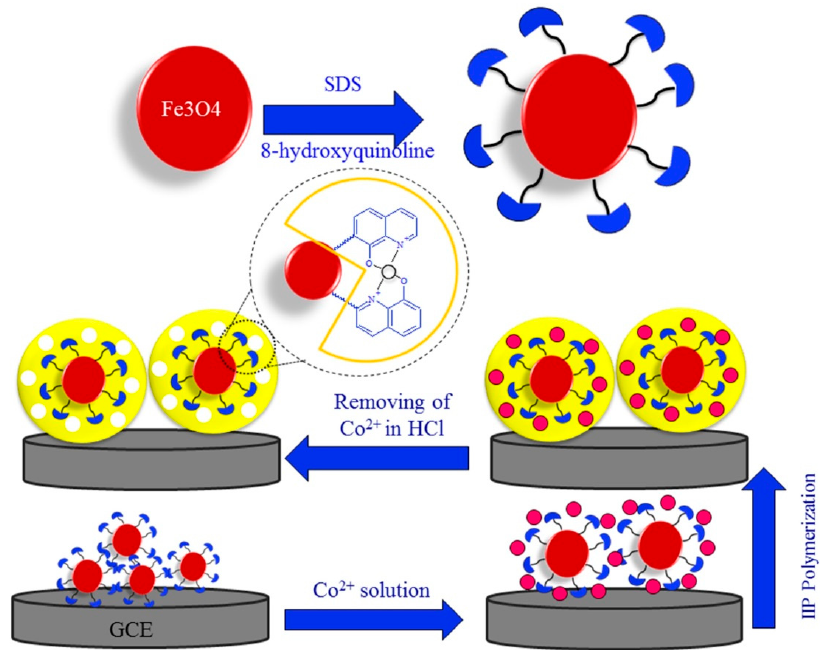
Figure 13. The modification process of Co(II)-IIP-Fe 3 O 4 electrode. Reprinted with permission from Ref. [61]. Copyright 2017, Elsevier.